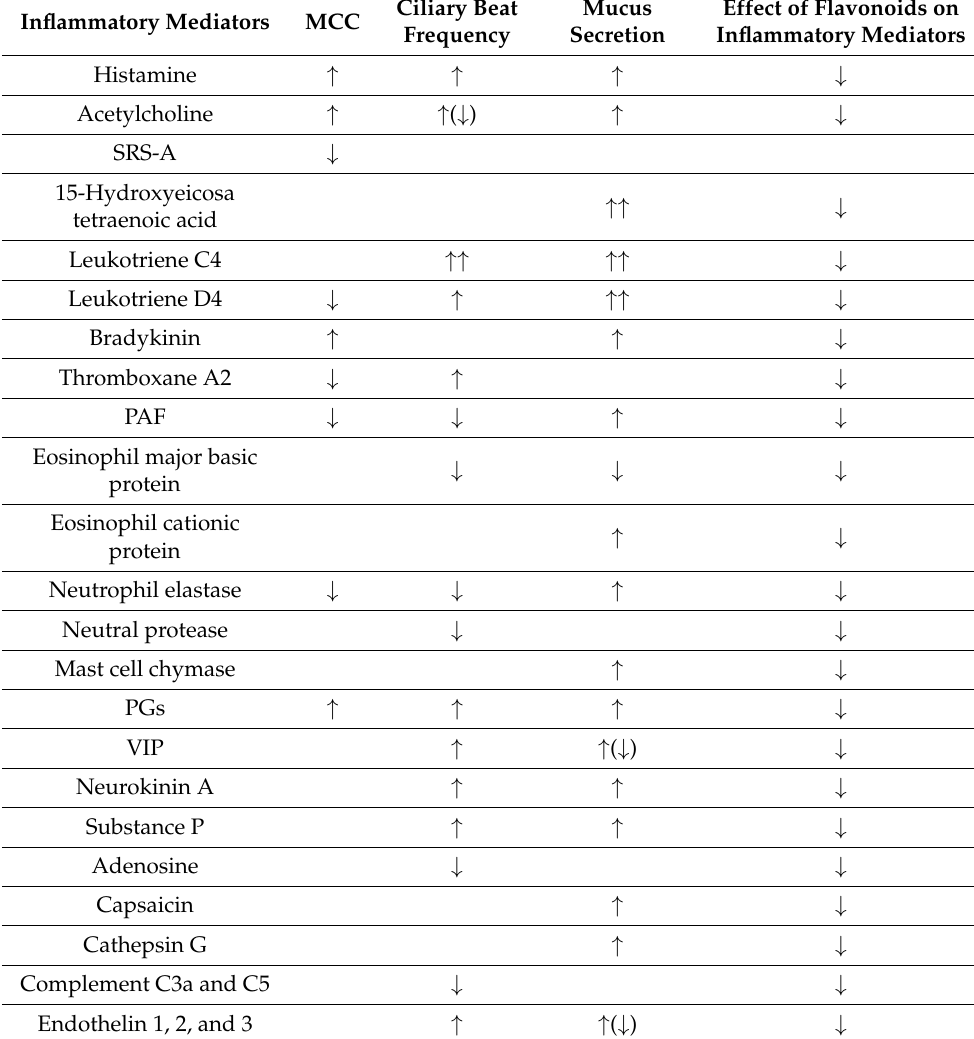
Table 10. Effects of inflammatory mediators on MCC, ciliary beat frequency, and mucus secretion * and modulation effects of propolis and its flavonoids on inflammatory